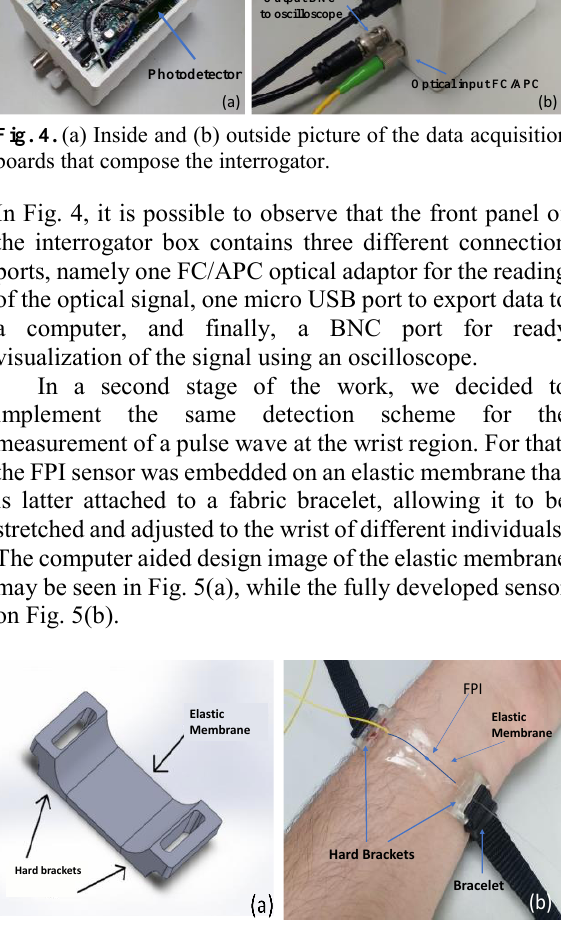
Fig. 5. (a) Drawing of the part used to measure the pulse wave and, (b) how it was implemented on the wrist